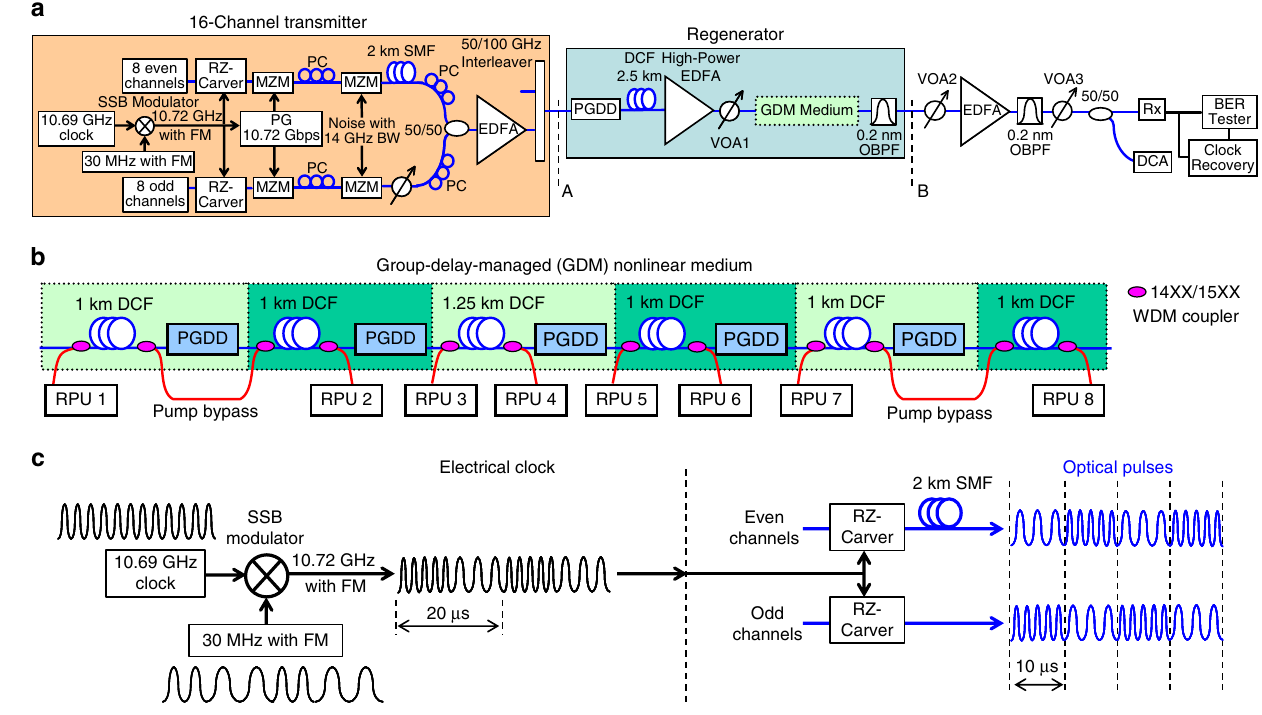
Fig. 5 Stand-alone regenerator setup. a 10-Gbps-modulated signals from a 16-channel transmitter enter the regenerator, and their performance is characterised by a pre-ampli fi ed receiver. b GDM medium in the stand-alone regenerator consists of six Raman-pumped sections of DCF, separated by fi ve PGDDs. PG: pattern generator, SSB: single sideband, SMF: single-mode fi bre, RPU: Raman pump unit. c Decorrelation of the even- and odd-channel clock frequencies by frequency modulation (FM) of a single clock